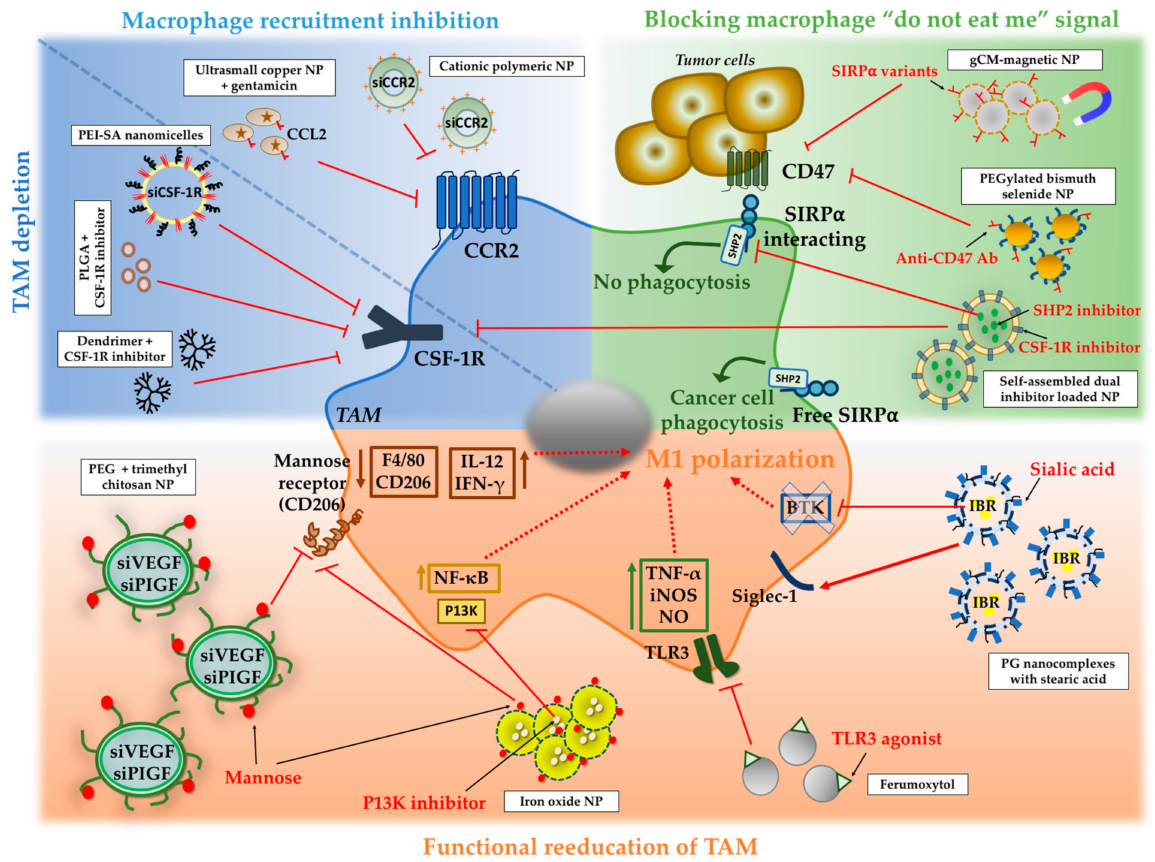
Figure 6. Strategies for the targeting of TAM using NPs. Four main strategies have been described for TAM-targeted therapies: (1) inhibition of macrophage recruitment to the tumor (blue); (2) TAM depletion in the tumor microenvironment (blue); (3) blockade of macrophage immune checkpoint (“do not eat me” signal) (green); and (4) functional re-education of TAM to a M1 phenotype (orange). The image illustrates different molecular targets and different types of NPs that have been described to treat TAM. NP: nanoparticles; PEI-SA: polyethylenimine and stearic acid; PLGA: poly (lactic-co-glycolic acid); CSF-1R: Colony stimulating factor 1 receptor; TAM: tumor-associated macrophages; CCR2: C-C Motif Chemokine Receptor 2; SHP2: Src homology region 2 phosphatases; SIPR α : macrophage signal-regulatory protein alpha; Ab: antibody; gCM: genetically engineered cell membrane; PEG: polyethylene glycol; VEGF: vascular endothelial growth factor; PIGF: placental growth factor; IFN γ : interferon γ ; NF- κ B: nuclear factor kappa-light-chain-enhancer of activated B cells; P13K: Phosphoinositide 3-kinases; TNF- α : tumor necrosis factor; iNOS: nitric oxide synthases; NO: nitric oxide; TLR: toll-like receptor; IBR: Ibrutinib; BTK: Bruton’s tyrosine